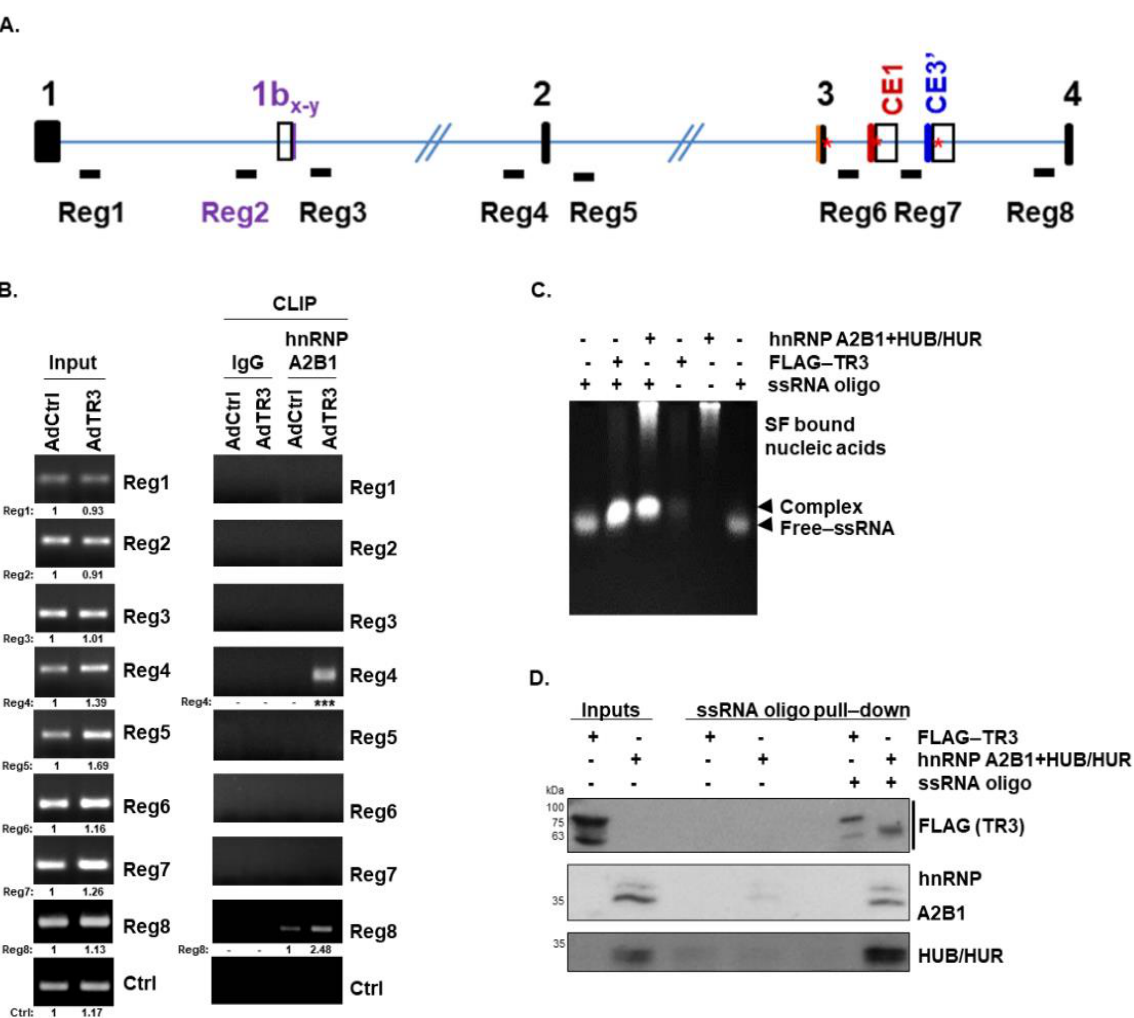
Figure 4. TR3 overexpression alters the recruitment of some splicing factors near splicing sites, interacting with AR pre-mRNA. ( A , B ) TR3 overexpression alters the recruitment of some splicing factors to AR pre-mRNA. Schematic presentation of intronic regions marked Reg1–8 in AR pre-mRNA, which were selected for CLIP analysis ( A ). CLIP analysis using anti-hnRNP A2B1 antibody showed an enrichment of hnRNP A2B1 at Reg4 and Reg8 within AR pre-mRNA in TR3-overexpressing CWR22Rv1 cells ( B ). Values below gels indicate the intensity ratio of the AdTR3-infected sample relative to AdCtrl-infected sample in each region. *** indicates the fold increase >5. ( C , D ) TR3 interacts with AR pre-mRNA. ssRNA protection assays performed using purified TR3 and splicing factors (hnRNP A2B1 and HUB/HUR) showed protection of a 30mer ssRNA oligo of AR-Reg4 labelled with biotin at the 5 (cid:48) end (ssRNA oligo) ( C ). ssRNA pull-down assays performed using the same purified protein fractions show the binding of TR3 and splicing factors to ssRNA oligo ( D ). Protein levels were analyzed via western blot analysis using anti-FLAG, anti-hnRNP A2B1, and anti-HUR antibodies. All uncropped western blot and gel original images are shown in Figure